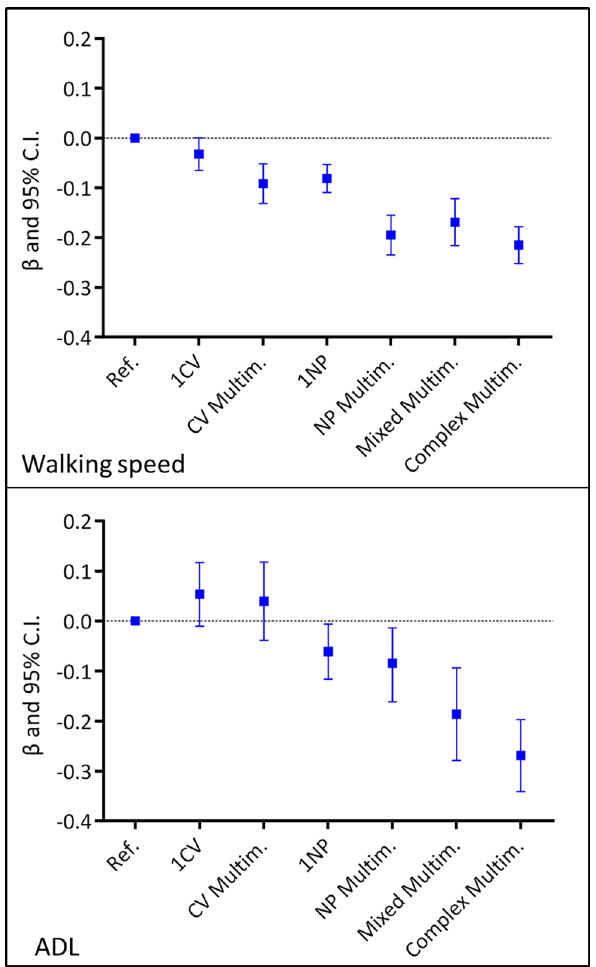
Fig 4. Association of chronic disease patterns with walking speed and number of intact ADL based on 6-year repeated measures of disease patterns, covariates, and outcomes. Multilevel mixed-effect linear regression models adjusted for age, sex, education, malnutrition, institutionalization, and number of medications. The exposure (the patterns of chronic diseases), the time-varying covariates (institutionalization, malnutrition, and number of medications), and the outcomes were introduced in the models as repeated measures. Reference group: participants free from CV/NP diseases. ADL, activities of daily living; CI, confidence interval; CV, cardiovascular; Multim., multimorbidity; NP, neuropsychiatric; Ref., reference